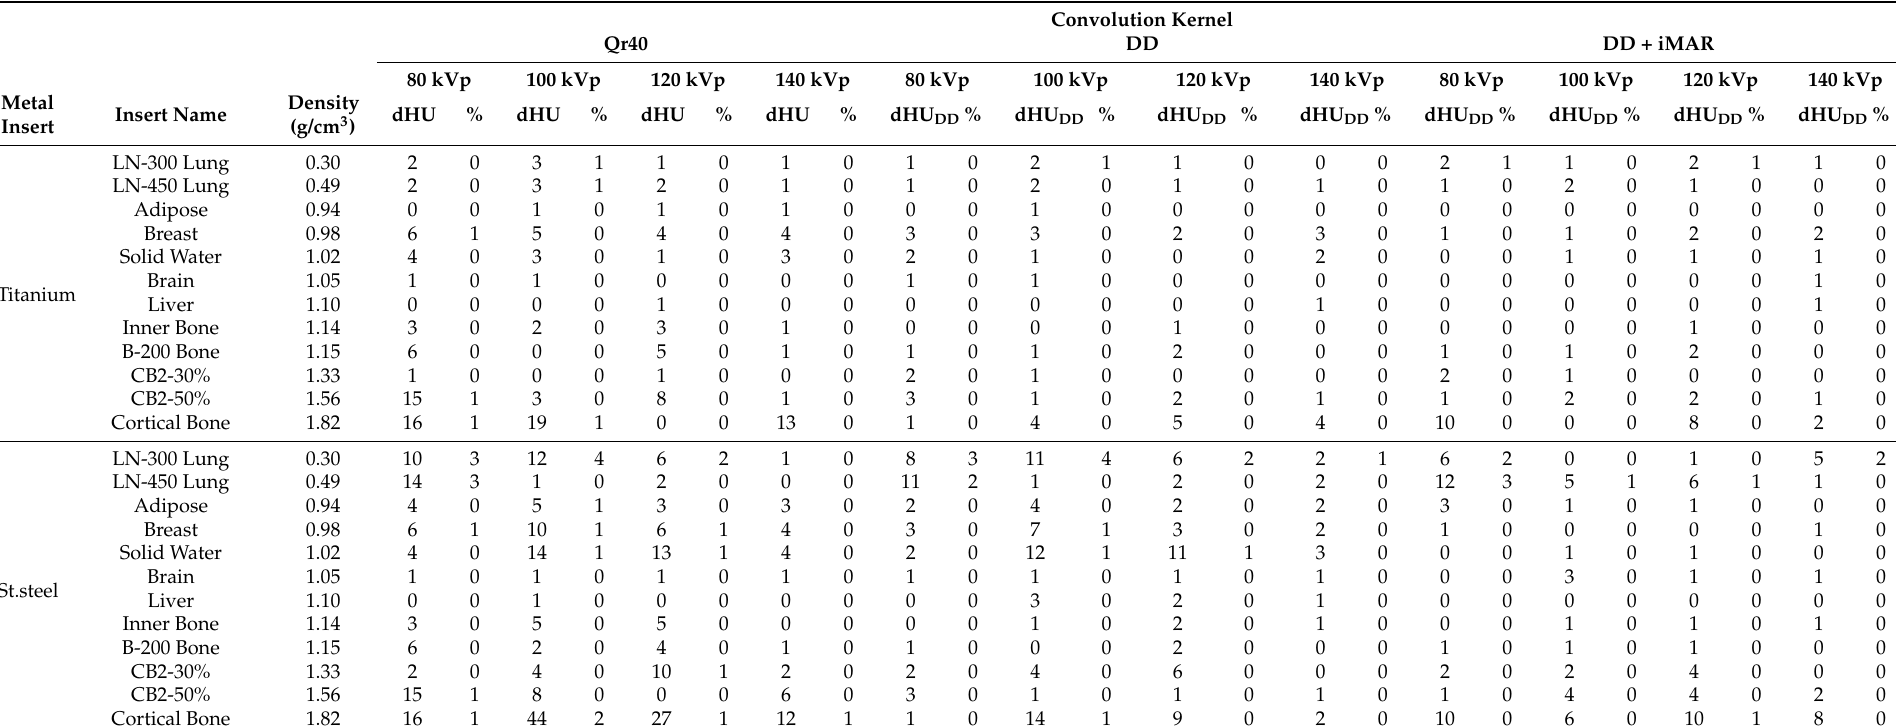
Table 3. The absolute and percentage differences in terms of HU or HU DD , for each non-metallic ROI, between the pairs of images acquired at the same kVp value and reconstructed with the same algorithm but one with and one without metal inserts (stainless-steel or titanium) in the phantom. For data related to the combined algorithm (DD + iMAR), variations were investigated with respect to the images acquired at different kVp without metallic materials and reconstructed with the DD convolution